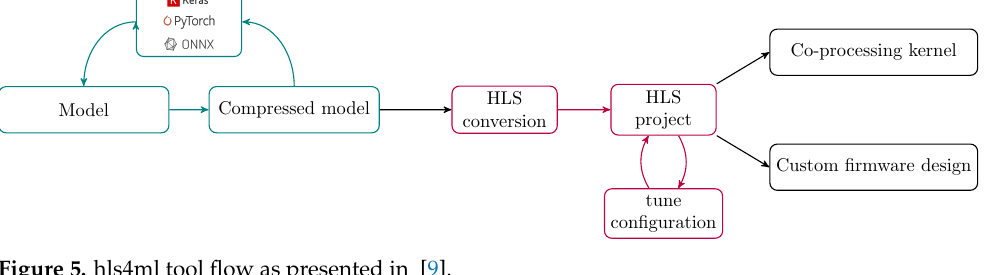
Figure 5. hls4ml tool flow as presented in